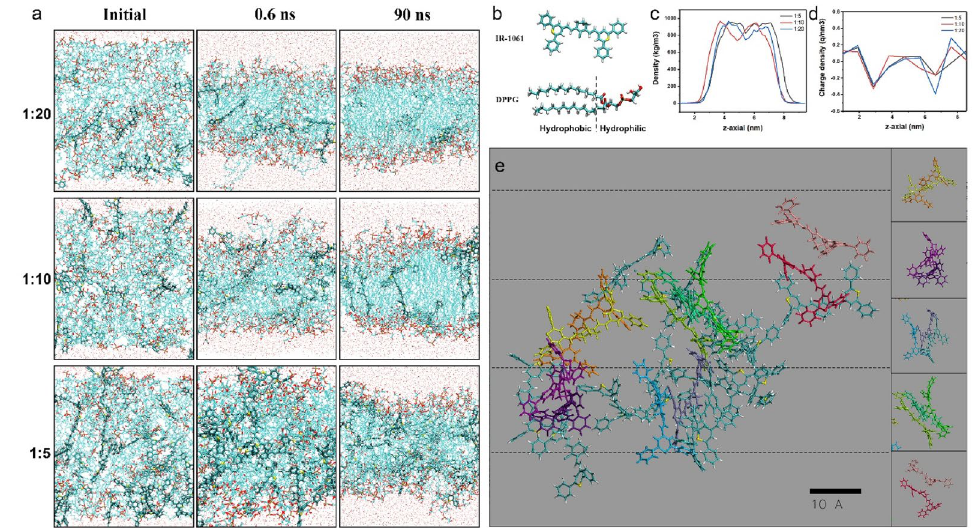
Fig. 2 Molecular dynamics simulation of IR-1061 in DPPG. a Operation procedure of systems with different number ratios of IR-1061 and phospholipid. b Molecular structure of IR-1061 and DPPG. c , d Mass density distribution and charge density distribution of systems after running for 90 ns. e The H-aggregated state of IR-1061 in the system (the number ratio of IR-1061 to DPPG is 1: 5) after running for 90 ns (dash line: distribution layers of IR-1061 in H-aggregated